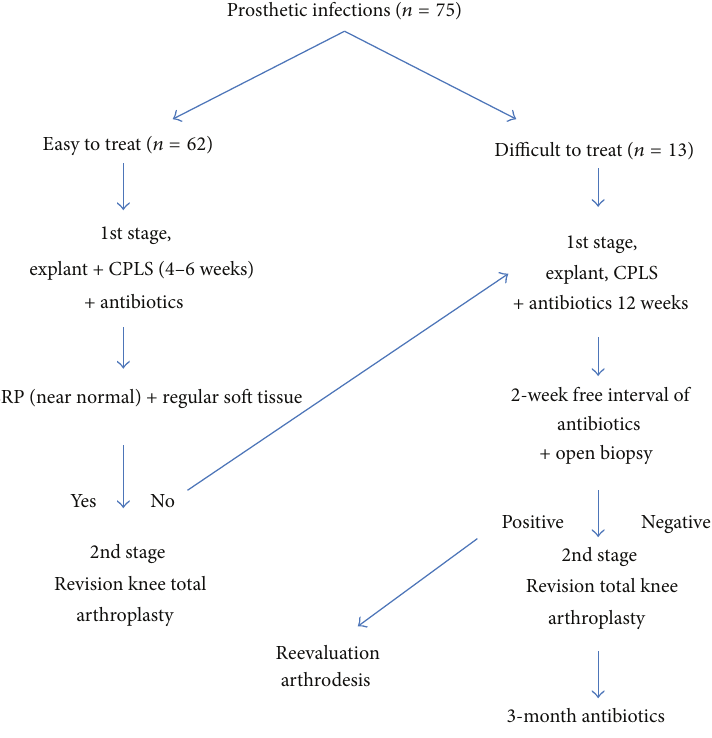
Figure 5: Protocol upon which the treatment strategy was